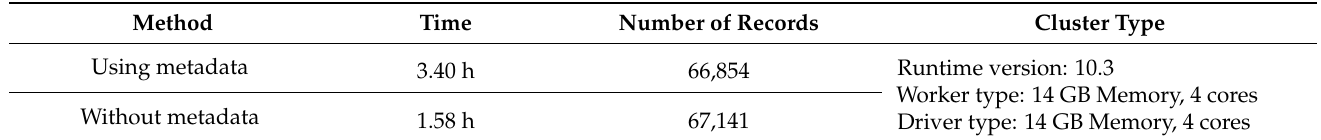
Table 2. Timing for web scraping.